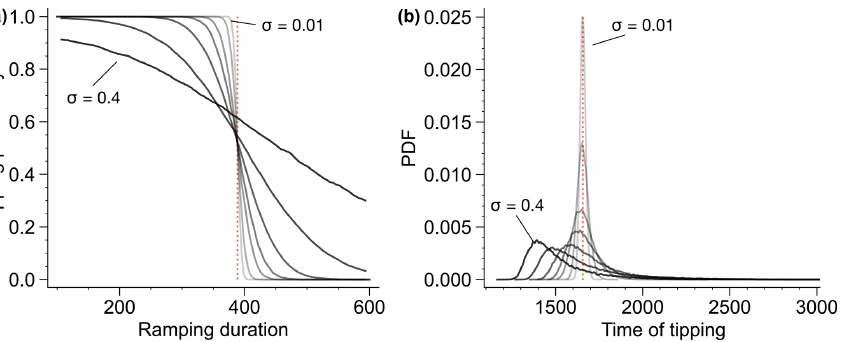
Figure 8. (a) Probability of a rate-induced tipping in the Stommel model from the off to the on state as a function of the linear parameter ramping duration from η 1 = 2 . 65 to η 1 = 3 . 00. Different noise levels σ T = σ S = σ are considered: σ = 0 . 01 (lightest gray curve), σ = 0 . 02, σ = 0 . 04, σ = 0 . 06, σ = 0 . 1, σ = 0 . 2, and σ = 0 . 4 (darkest gray curve). The dashed red line is the critical ramping duration in the deterministic system. (b) Probability distributions of the time of tipping, defined by the first crossing of q > 0 . 1, for different noise levels. The ramping is started in year 1000 and the duration is fixed at 300 years. The dashed red line is the time of tipping in the deterministic